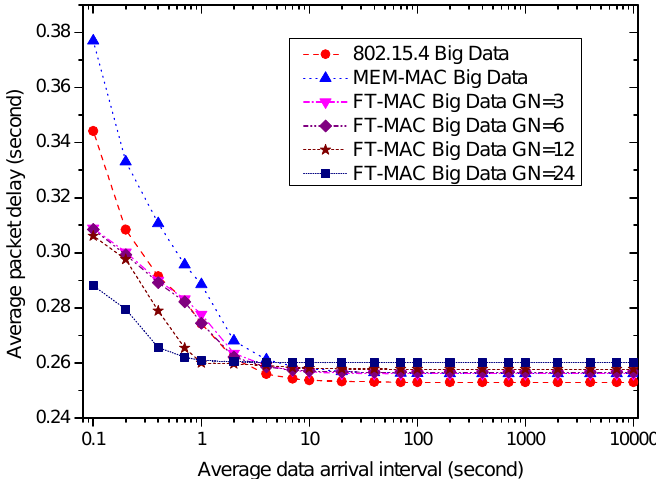
Figure 25. The effect of the average data arrival interval on average big data